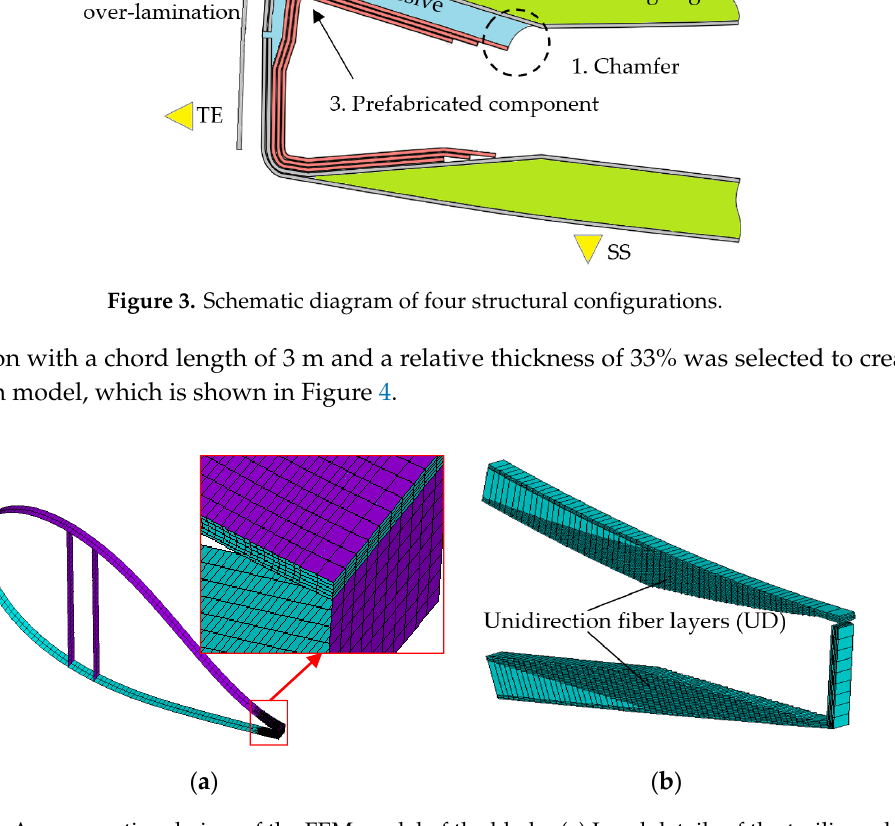
Figure 3. Schematic diagram of four structural configurations.